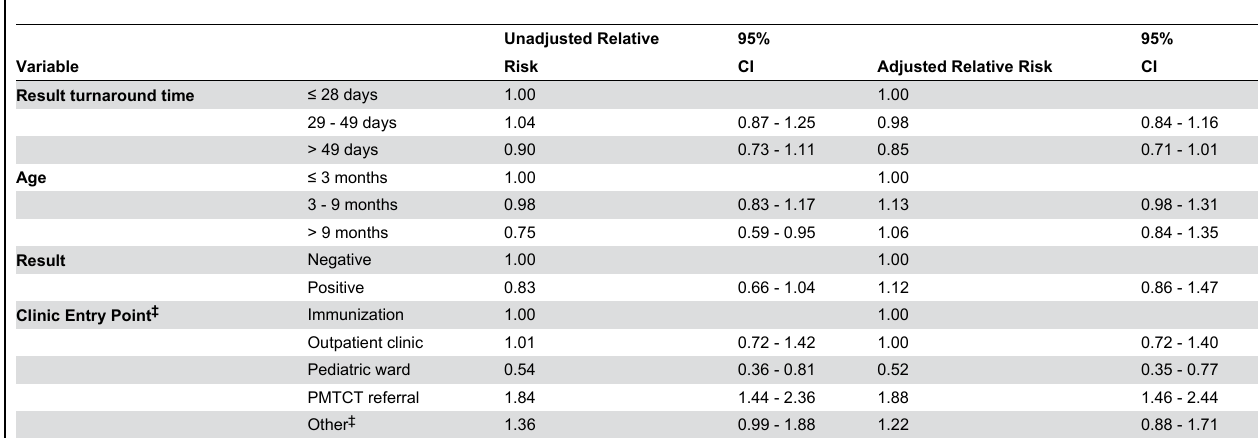
Table 5. Unadjusted and Adjusted Analysis for Result Receipt at the Regional Referral Hospital.